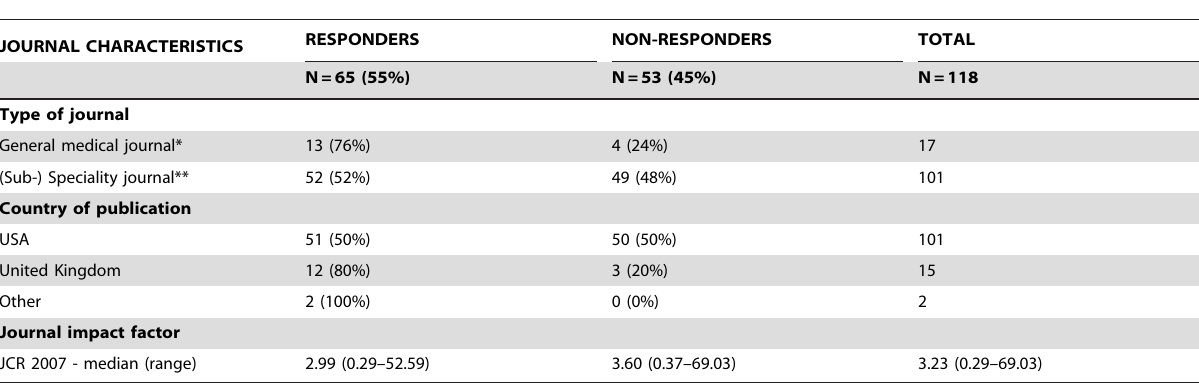
Table 1. Journal characteristics by survey responder status.